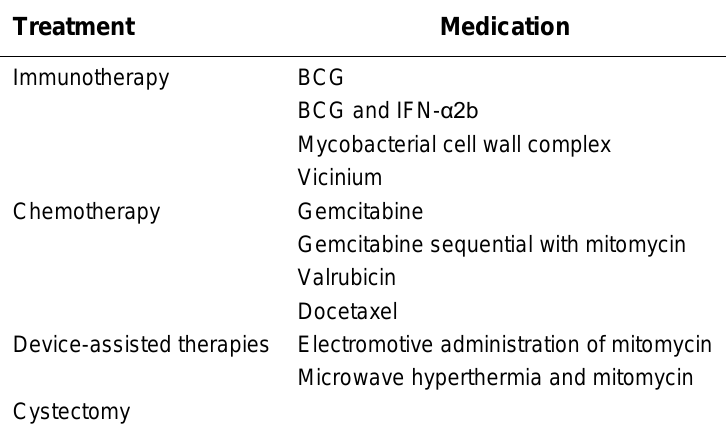
Treatments Studied in Patients with BCG